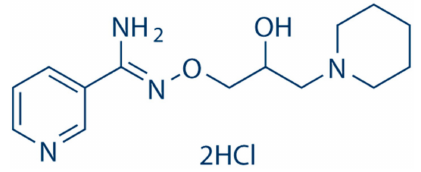
Figure 1. Chemical structure of BGP-15